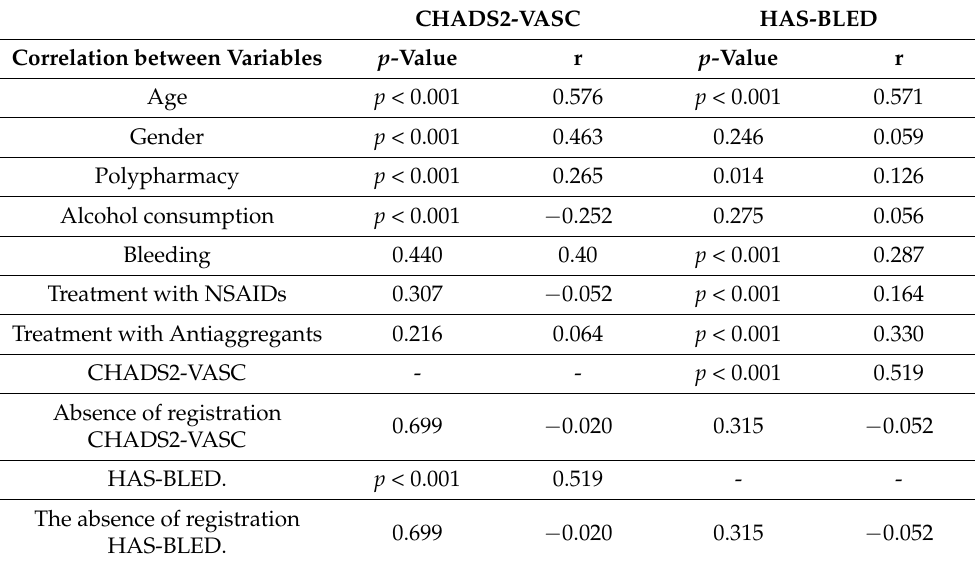
Table 2. Correlation of variables with CHADS2-VASC and HAS-BLED. CHADS2-VASC HAS-BLED Correlation between Variables p- Value r p- Value r Age Gender p < 0.001